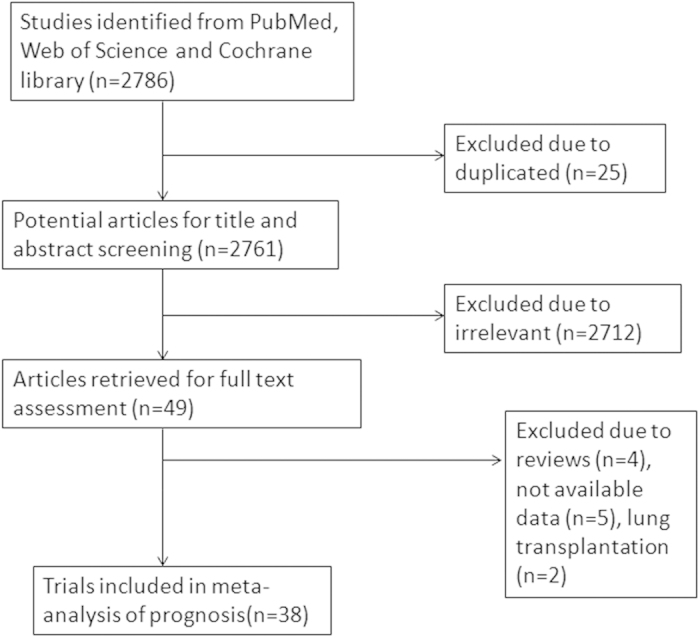
Flow chart of study selection.